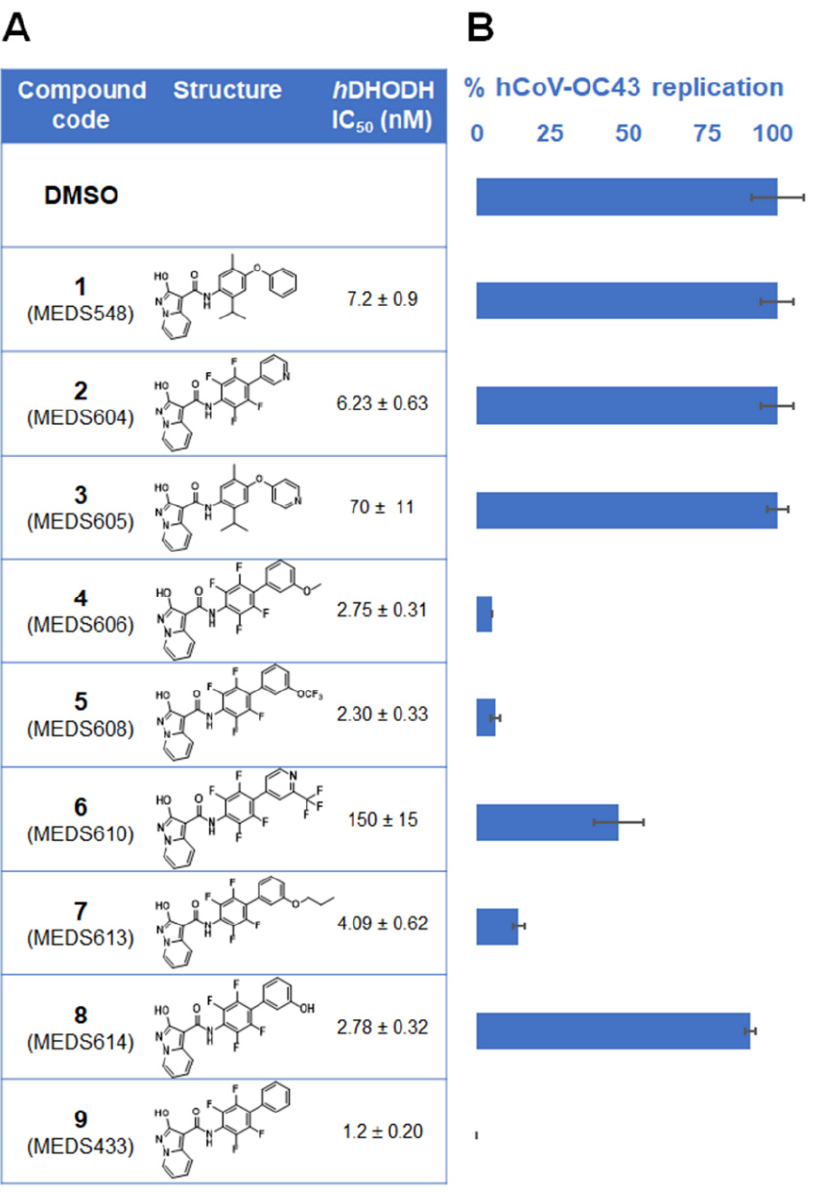
Figure 1. Selection of h DHODH inhibitors with anti-hCoV activity. HCT-8 cells were pretreated and treated vehicle (DMSO) or with 0.1 µ M of the different h DHODH inhibitors showed in ( A ) 1 h prior to, during infection with hCoV-OC43 (100 PFU/well), and throughout the experiment. At 72 h p.i., viral foci were immunostained and the mean foci number in treated culture compared to that of DMSO-treated and hCoV-OC43-infected control HCT-8 cell monolayers. The replication rates shown in ( B ) represent means ± SD (error bars) of three independent experiments performed in